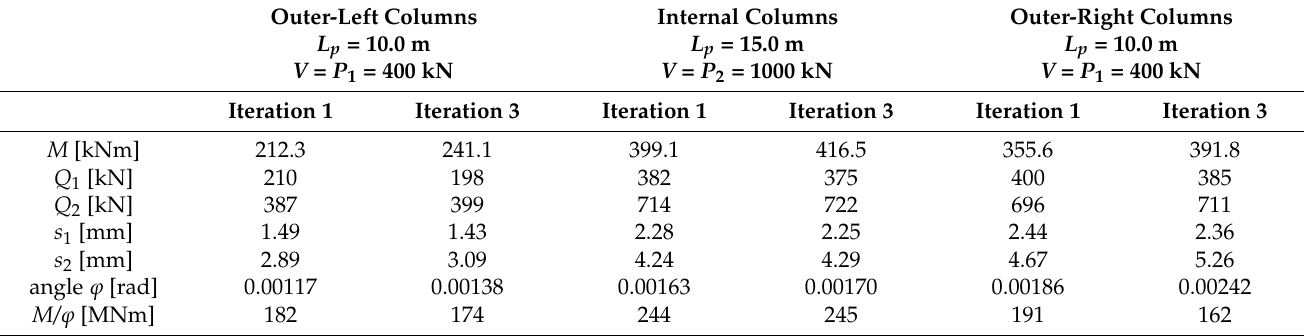
Table 3. Results of the pile settlement calculations in the column supports; Example